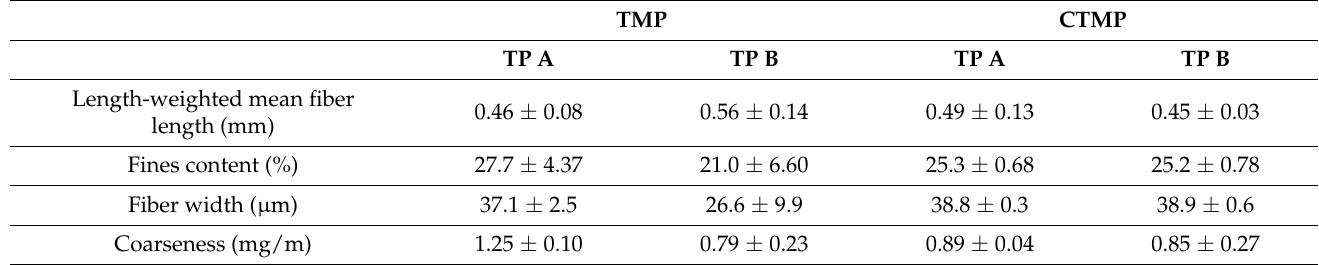
Table 6. Comparison of fiber properties according to the different plates.